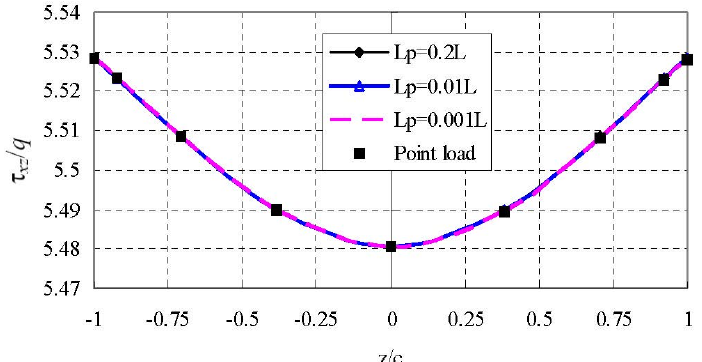
q ) for sandwich panels under xz